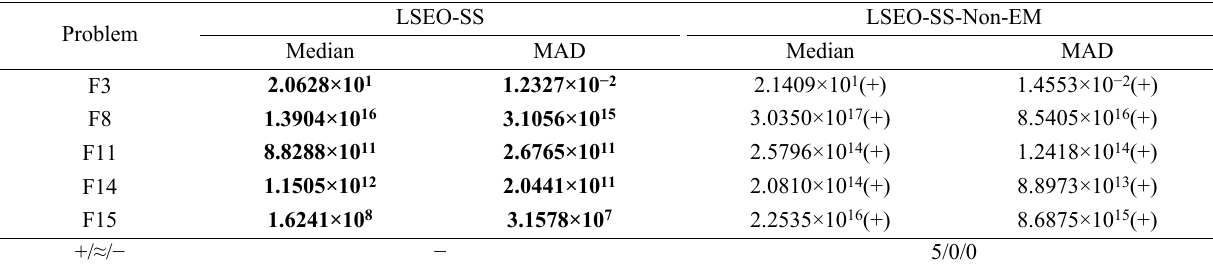
Table 4 Statistical results of the optimal objective values, given in median and median absolute deviation (MAD), of LSEO-SS and LSEO-SS-Non-EM on F3, F8, F11, F14, and F15 problems. Problem